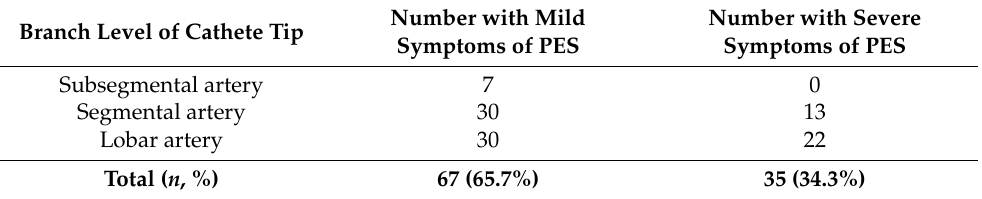
Table 3. Branch level of catheter tip associated with incidence and severity of postembolization syndrome